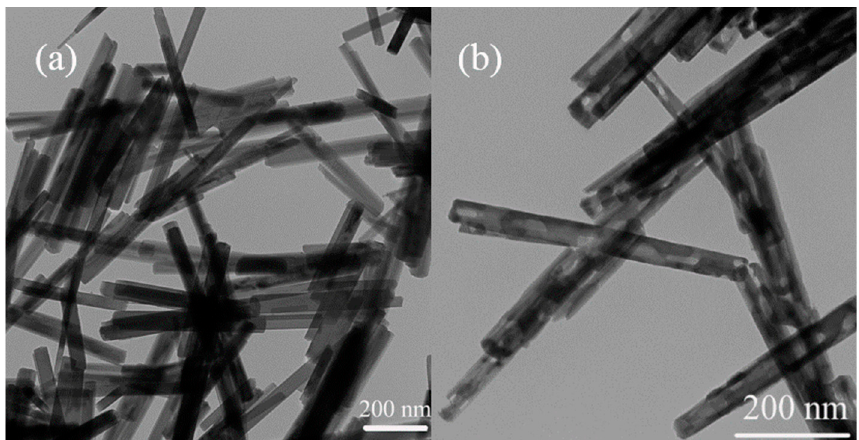
Figure 2. TEM images of uncalcined ( a ) and calcined ( b ) precursors prepared by the aqueous precipitation method.